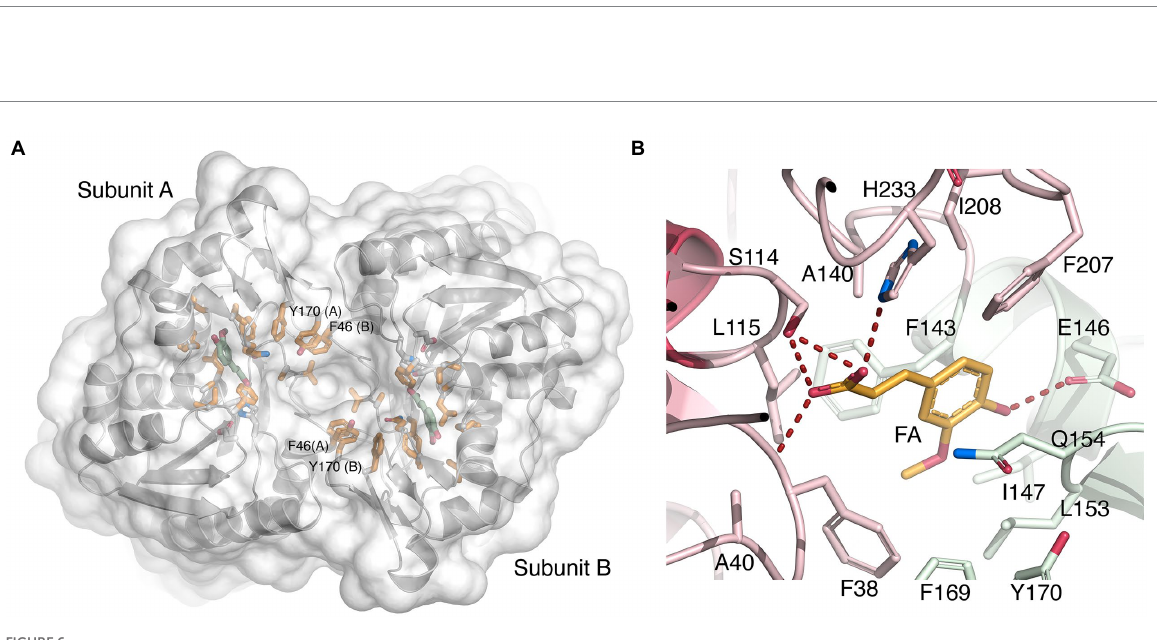
FIGURE 6 Binding of ferulate to Lb FAE. (A) Ribbon drawing of the Lb FAE homodimer with an overlaid water-accessible surface viewed from the entrance to the active-site groove (view from bottom as in Figure 4B). The ferulate molecule is colored green, and hydrophobic residues lining the groove are colored orange. An arc of aromatic residues from each monomer (Phe207-Phe38-Phe169-Tyr169-Phe46) form an oval collar around the active- site entrance. The narrow opening to the active sites is seen as a deep indentation at the center of the dimer. (B) Details of the key enzyme-ligand interactions. The ferulate molecule is colored orange, and residues belonging to the core and lid domains are colored red and green, respectively. See text for additional